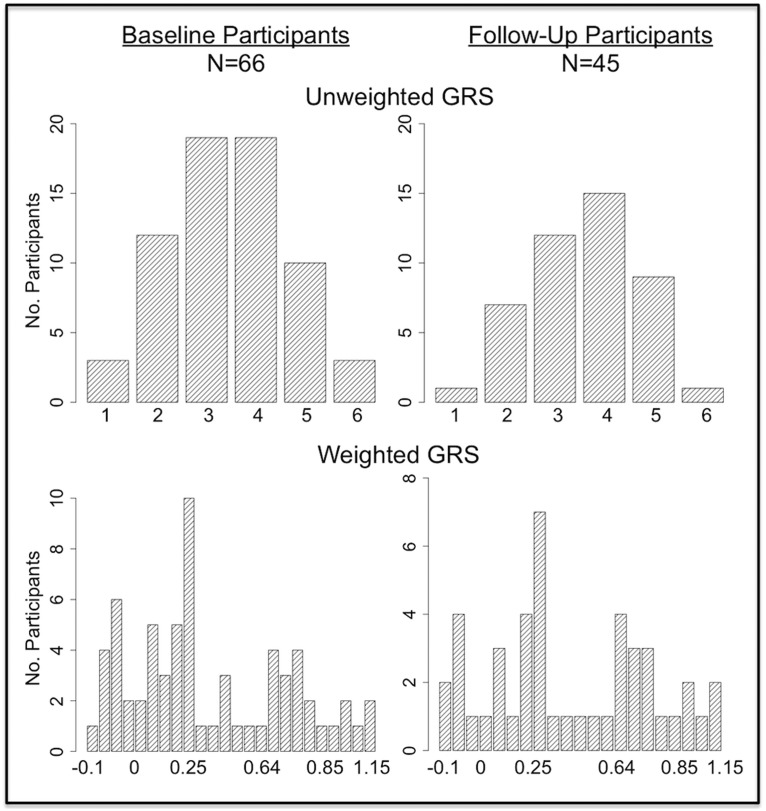
Distribution of genetic risk scores. Participants’ risk scores were normally distributed across the range of possible scores. No participants had zero genetic risk factors nor did any have the maximum of seven risk factors. There were no differences in either unweighted risk score or weighted risk score distributions between the baseline cohort (n = 66) and the subset of participants with longitudinal data (n = 45).